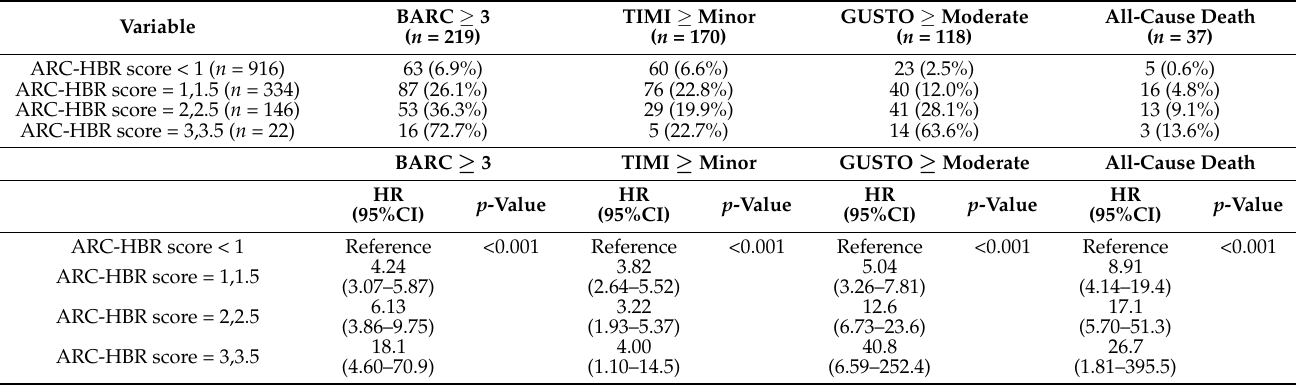
Table 4. Risk of clinical events according to Academic Research Consortium for High Bleeding Risk (ARC-HBR)